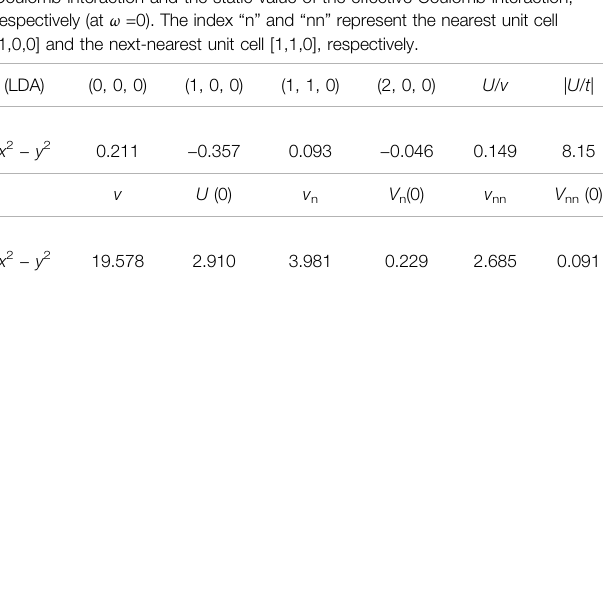
TABLE A2 | Transfer integral and effective interaction in the one-band Hamiltonian forYNiO 2 (ineV).Theone-bodypartisderivedbasedontheGWbandstructure, andtheeffectiveinteractionistheresultofthecRPAcalculationfortheGWbands. v and U (0)representthebareCoulombinteractionandthestaticvalueoftheeffective Coulombinteraction,respectively(at ω =0).Theindex “ n ” and “ nn ”